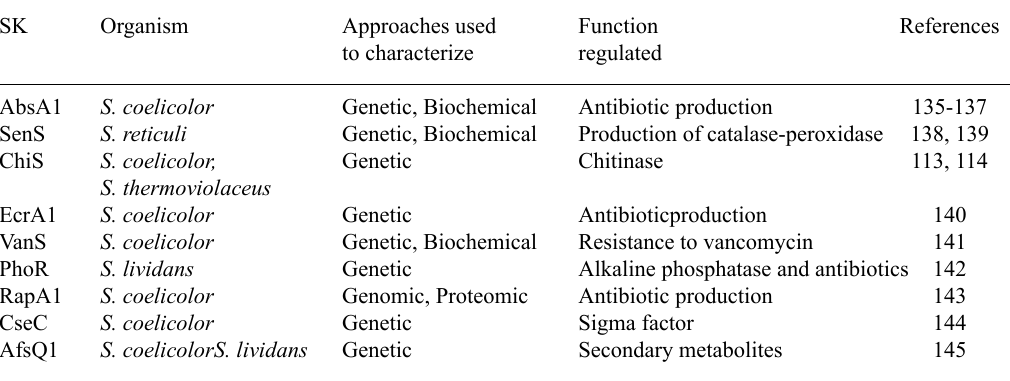
Table 3. Characterized sensor kinases from Streptomyces SK